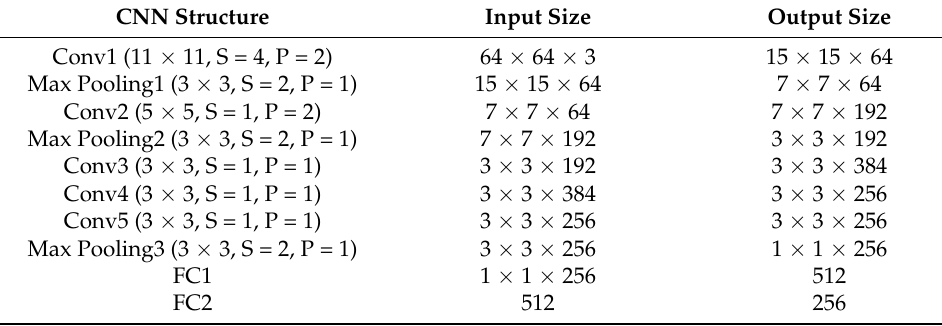
Figure 1. The extraction process for spectral convolutional features. Table 1. Layers and output size and architecture of